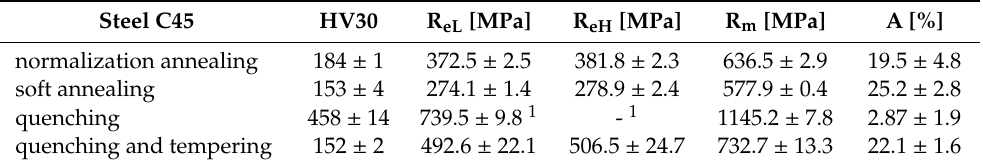
Table 4. Vickers hardness HV30, lower R eL and upper R eH yield strength, ultimate tensile strength R m , percentage elongation after fracture